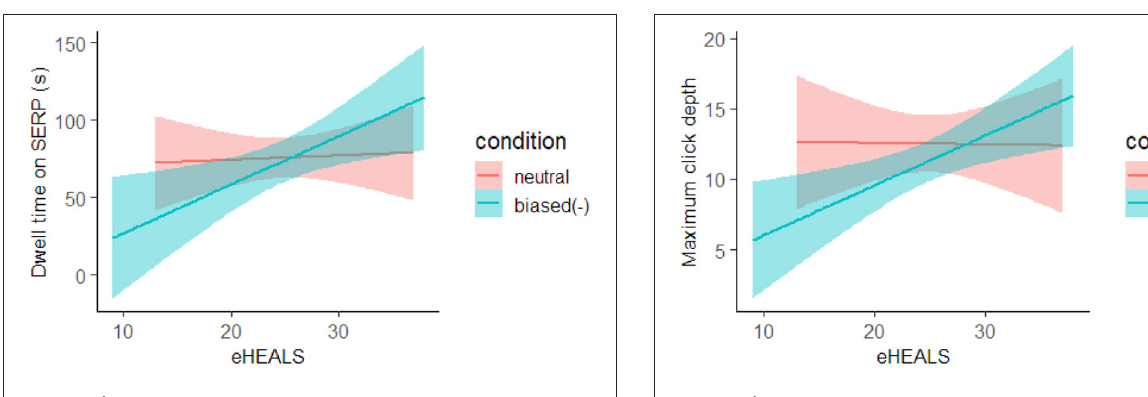
FIGURE 3 | Estimated effect of condition and eHEALS on SERP dwell time. The red line represents the NEUTRAL group, and the blue line represents the BIASED( − ) group. The background color indicates the confidence interval.